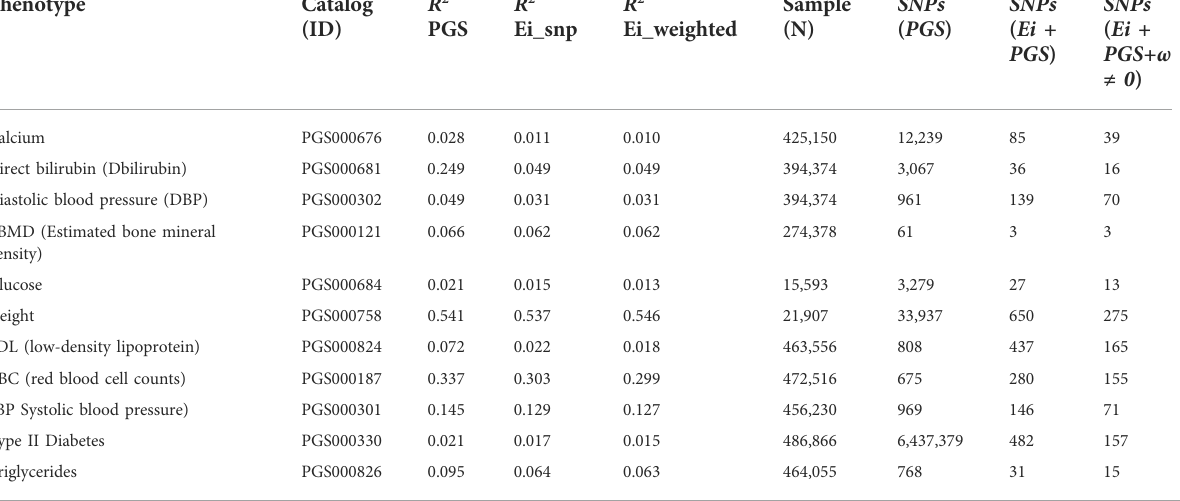
TABLE 5 Predicted R -squared values, sample size and numbers of SNPs used, when using PRS to predict eleven phenotypes for three different PRS constructions. CatalogID :thePGScatalogIDwhichwasusedtoidentifySNPs. R 2 PGS : R 2